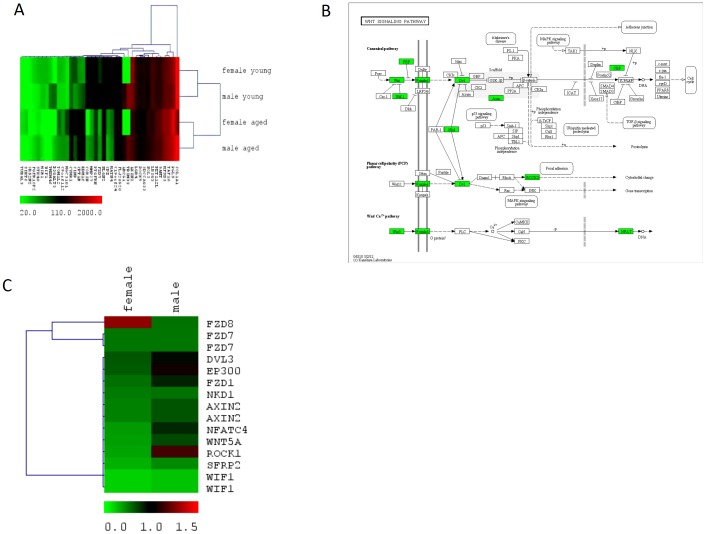
Hierarchical clustering of genes that overlap in aged samples, irrespective of sex (A); Age dependent changes in WNT signalling of males and females (B); Hierachical clustering showing a similar expression profile in young subjects for genes regulated by age in WNT-signalling (C).(A) All relevant genes are listed according to their average expression values. Each column corresponds to one gene, each row to 4 replicates for each group sample. Green indicates a low expression value and red a high expression value. Black corresponds to a median expression value in relation to all shown values. Euclidean Distance was used to calculate average linkage clustering of the sample and gene tree. (B) The KEGG-pathway shows genes which are negative regulated with age in green colour. (C) All relevant genes are listed according to their expression values shown as log2. Each row corresponds to one gene, each column to 4 different microarray experiments. Green indicates a low expression value and red a high expression values. Black corresponds to a median expression value in relation to all shown values.